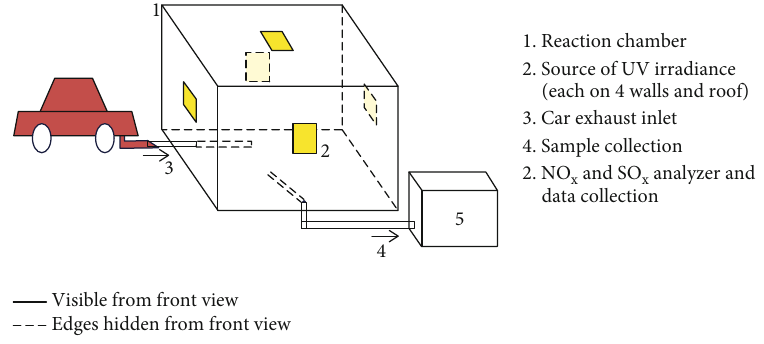
Figure 1: Brief sketch of the experimental site. Table 1: Three levels of the process parameters used during the optimization process. S.